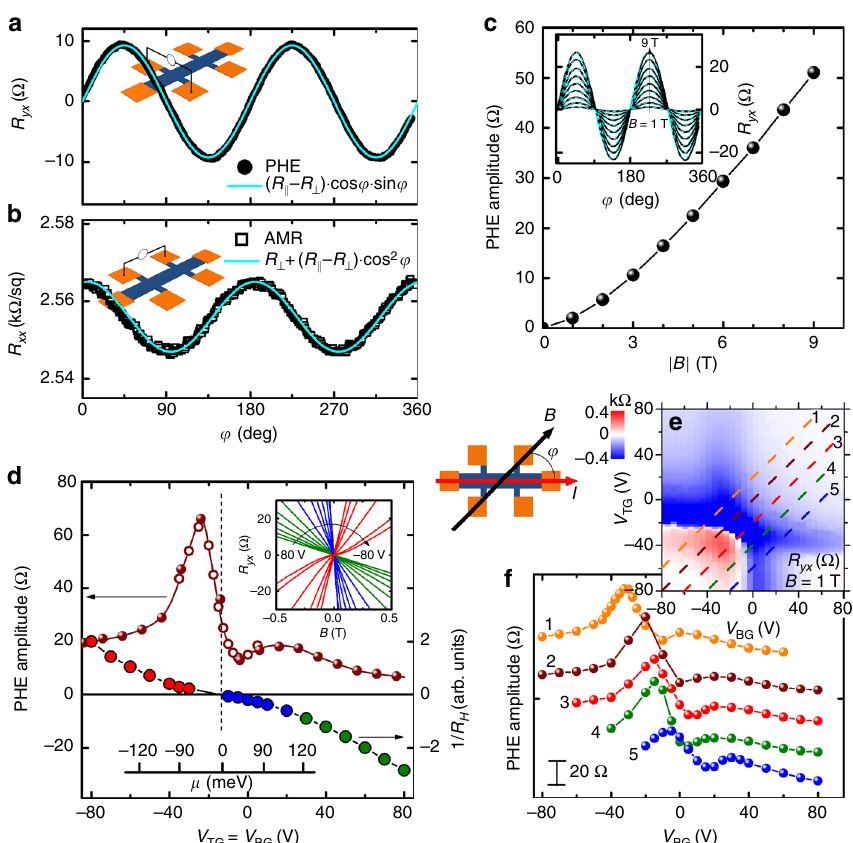
Fig. 2 Planar Hall effect. a Angular dependence of the planar R yx data at V TG = V BG = 5V measured at 2K in the magnetic fi eld of 9T rotated in the fi lm plane (inset shows the con fi guration); blue solid line is a fi t to ( R k (cid:2) R ? )cos φ sin φ , where φ is de fi ned in the central inset. b Angular dependence of R xx in the same conditions as in a ; blue solid line is a fi t to ( R k (cid:2) R ? )cos 2 φ . c Magnetic- fi eld dependence of the PHE amplitude ( (cid:6) R k (cid:2) R ? ) at V TG = − 80 V and V BG = 80V; inset shows the raw R yx ( φ ) data and their fi ts in various B . d Gate – voltage dependence of the PHE amplitude for V TG = V BG in the in-plane 9-T fi eld (left axis) and the effective total carrier density (right axis), obtained from the low- fi eld Hall data (shown in the inset); vertical dashed line marks the Dirac-point crossing, and the scale-bar inset depicts the estimated change of the Fermi level. e Color mapping of R yx ( V TG , V BG ) measured in the out-of-plane 1-T fi eld, on which different dual-gating paths for the PHE-amplitudes measured in the in-plane 9-T fi eld shown in f are indicated; curves in f are shifted vertically for